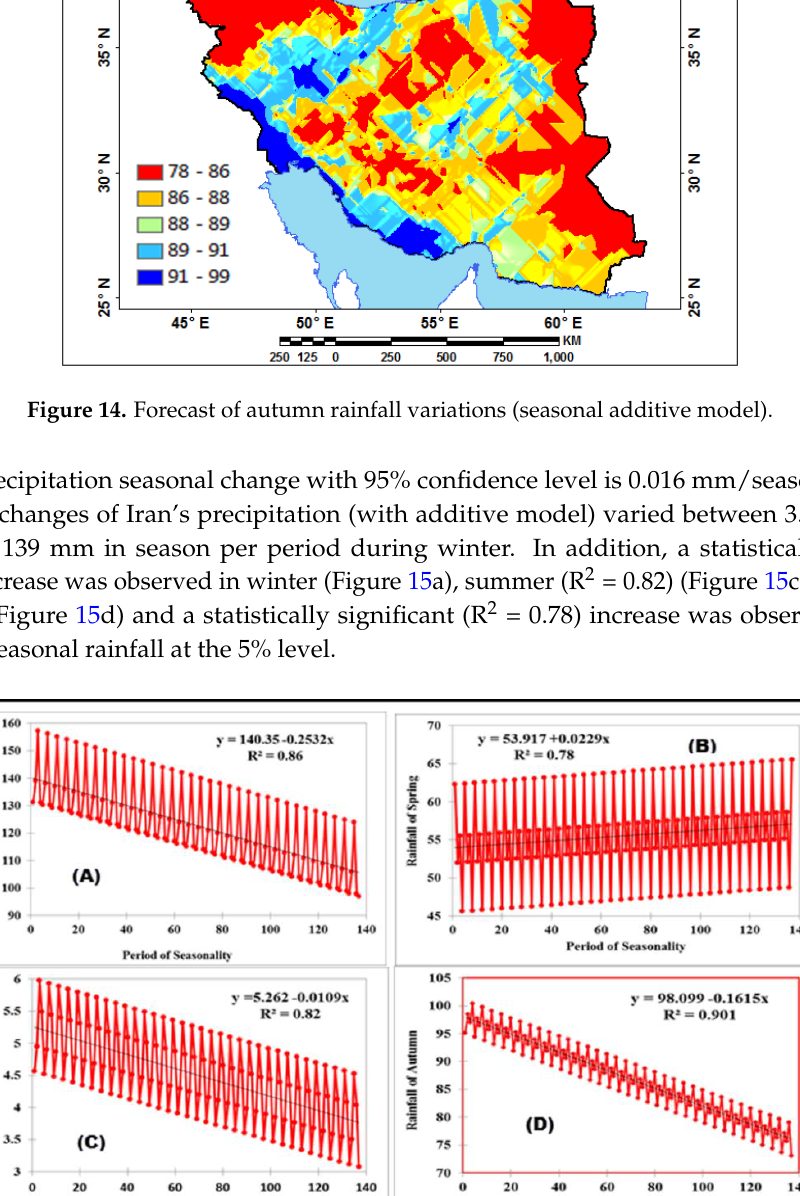
Figure 16. Trend changes percent of forecasted seasonal rainfall. The maximum decrease in trend changes percent in predicted seasonal rainfall was in summer (57.7%) followed by winter (53.5%), autumn (49.6%) and spring (32.4%) rainfall (9.87%) series. A robust negative trend, up to 0.031 mm per decade, was detected in the central, eastern and southern Iran and a robust positive trend, up to 0.006 mm per decade, was observed in northern and eastern Iran. The results in the area of forecasting the seasonal additive model are presented in Figure 17.